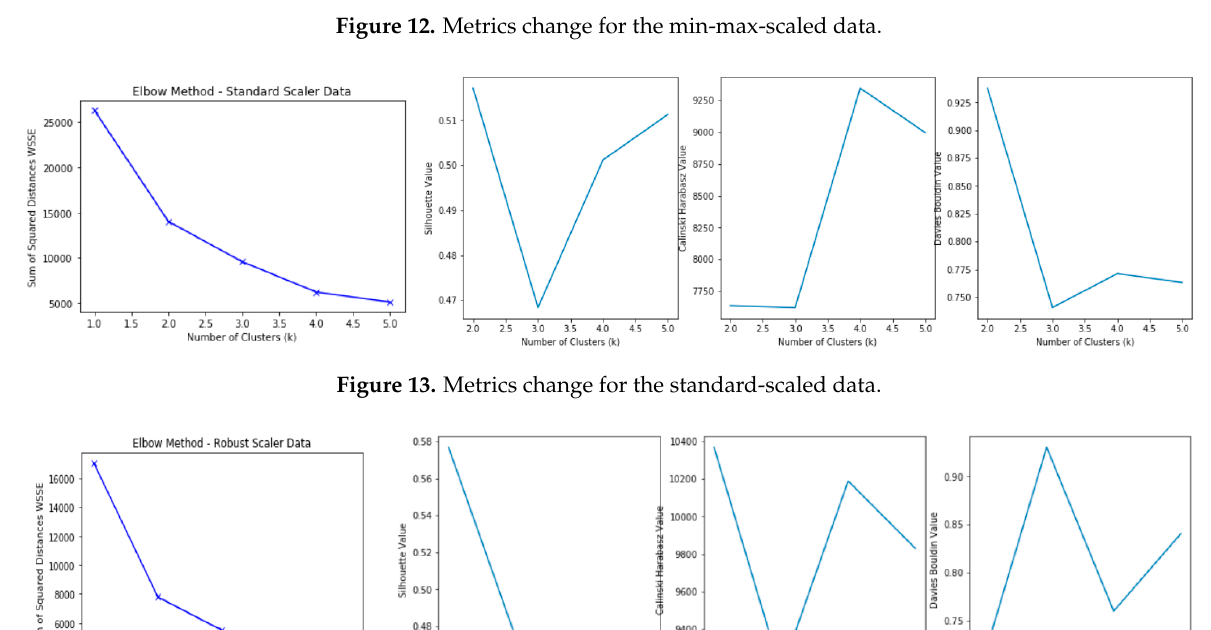
Figure 13. Metrics change for the standard-scaled data .